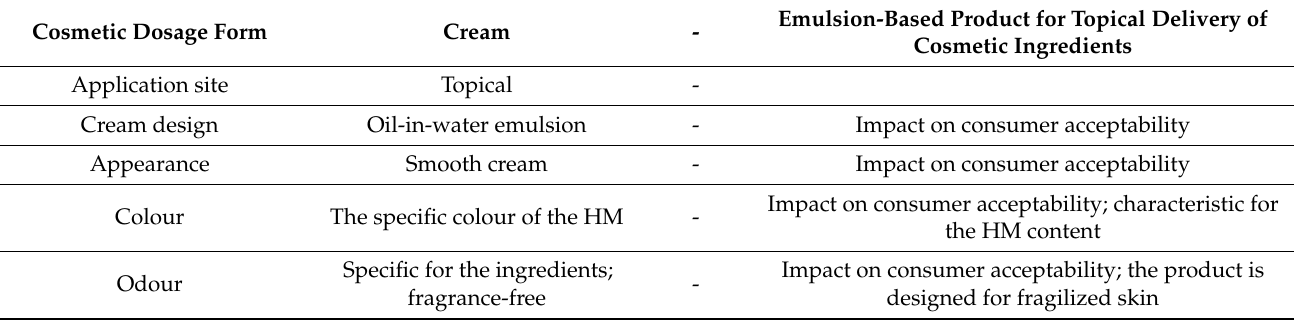
Table 9. QTPP and QAs of the developed oil-in-water